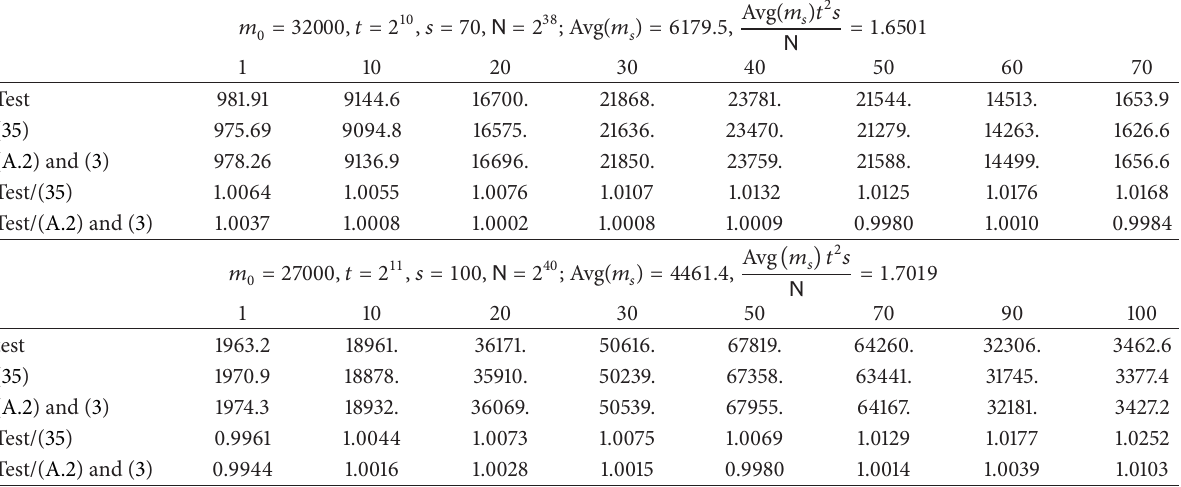
Table 3: Experimental verification of theoretically obtained expected cost of resolving a possible alarm associated with an online chain that starts from the 𝑖 th